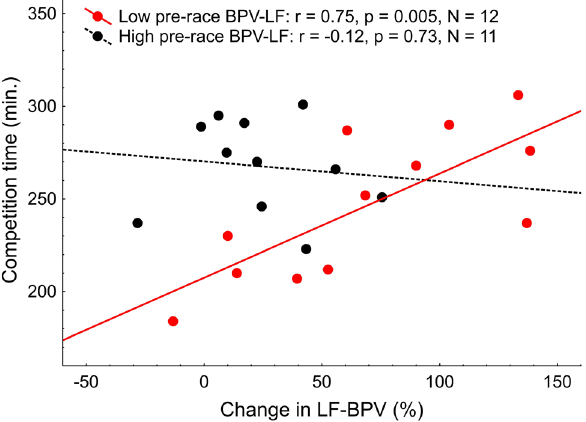
Figure 7. The competition time plotted against the pre- versus post-race change in LF-BPV in the subjects with low (in red) and high (in black) pre-race